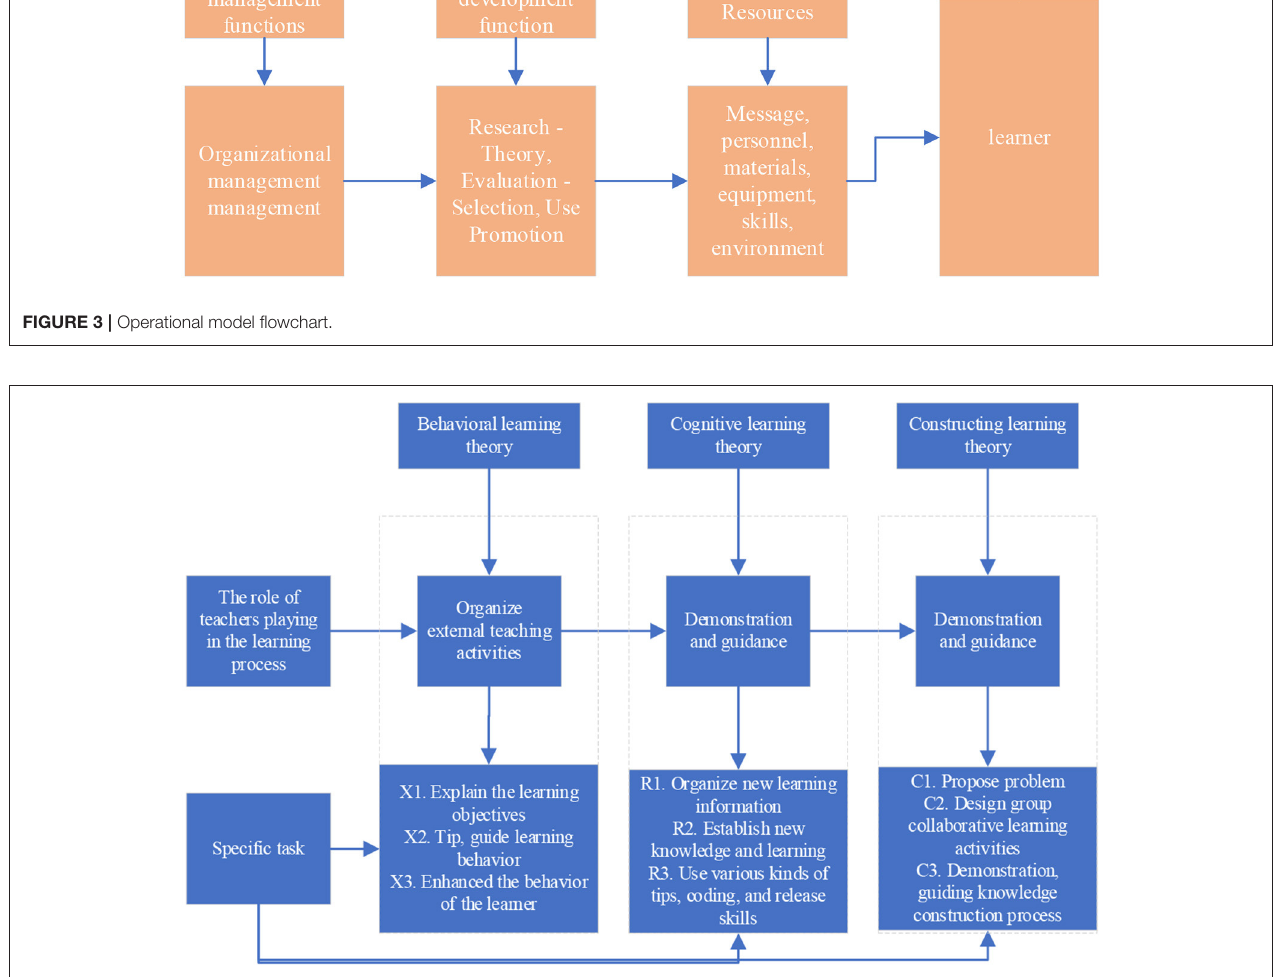
FIGURE 4 | Flowchart of the specific tasks of the teacher’s